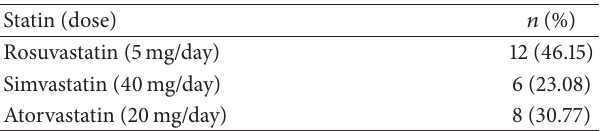
Table 2: Different statin